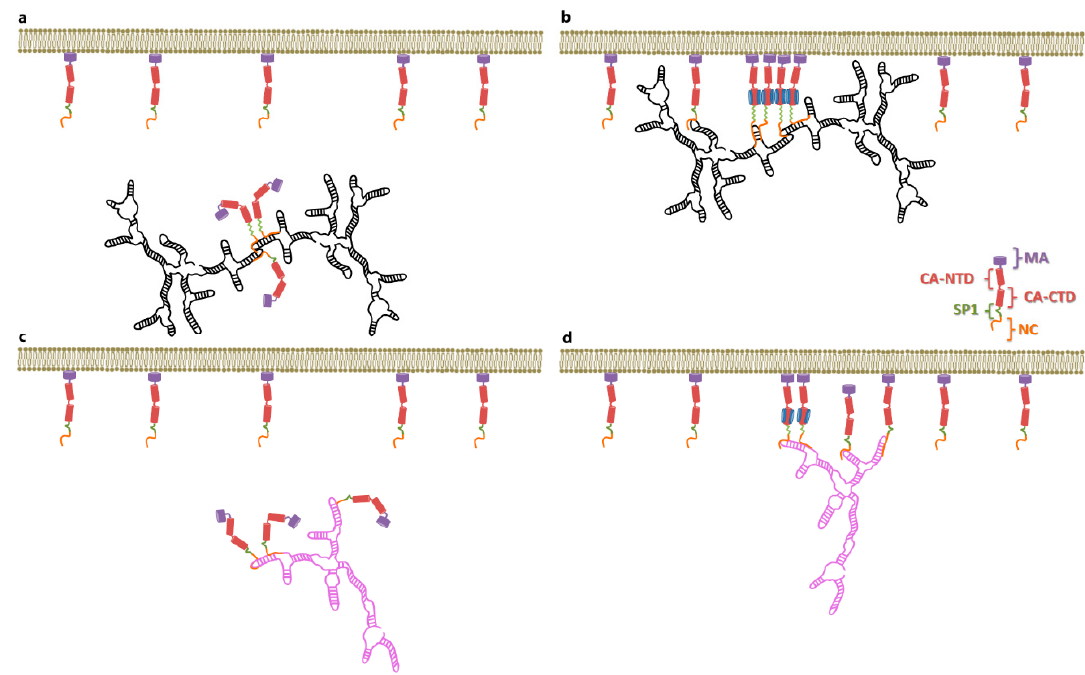
Figure 4. Schematic representation of the binding of HIV-1 Gag to the dimeric HIV-1 genomic RNA (gRNA) ( a , b ) and to non- Ψ RNA ( c , d ). ( a ) In the cytoplasm Gag binds to the HIV-1 gRNA by recognizing the RNA dimeric interface. Binding of Gag to Ψ increases the local concentration of Gag, thus promoting a conformational change in the SP1 domain from a random coil to an α -helix (green portion of Gag); ( b ) Once the HIV-1 Gag–dimeric gRNA complexes are bound to the plasma membrane, the specific Gag–RNA interactions promote a conformational change in Gag that enables high-order Gag–Gag interactions (blue interface); ( c ) In the absence of the HIV-1 gRNA Gag binds to mRNAs; however, because these interactions are non-specific, a higher Gag concentration is required to induce the conformational change in Gag; ( d ) When Gag–non- Ψ RNA complexes are bound to the plasma membrane, the local concentration of Gag is high enough to promote high-order Gag–Gag interactions. MA: matrix; CA-NTD: N-terminal domain of the capsid; CA-CTD: C-terminal domain of the capsid; SP1: spacer 1; NC: nucleocapsid.